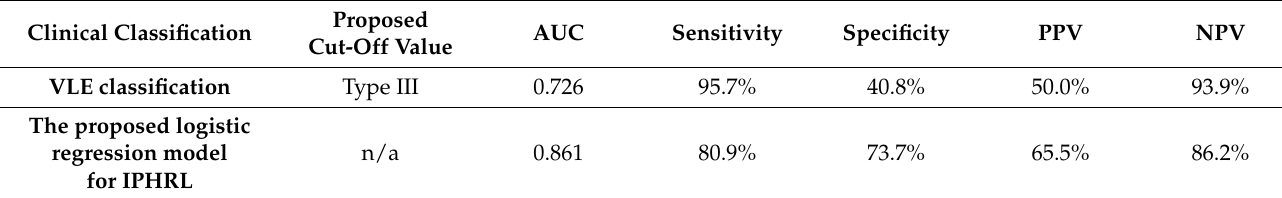
Table 6. Diagnostic value of VLE